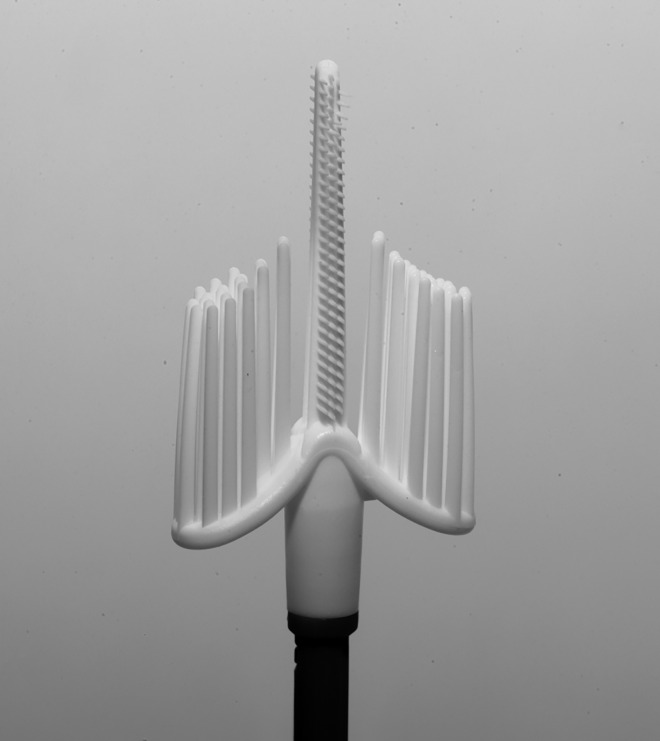
Cervex-Brush® Combi.